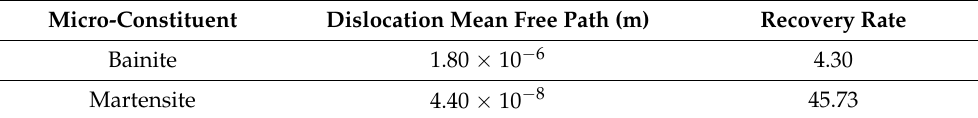
Table 7. The calibrated values of dislocation mean free paths and recovery rates for bainite and martensite in the as-quenched microstructures of Ductibor ® 1000-AS used in Rodriguez and Gutier- rez’s model (Equation (8)